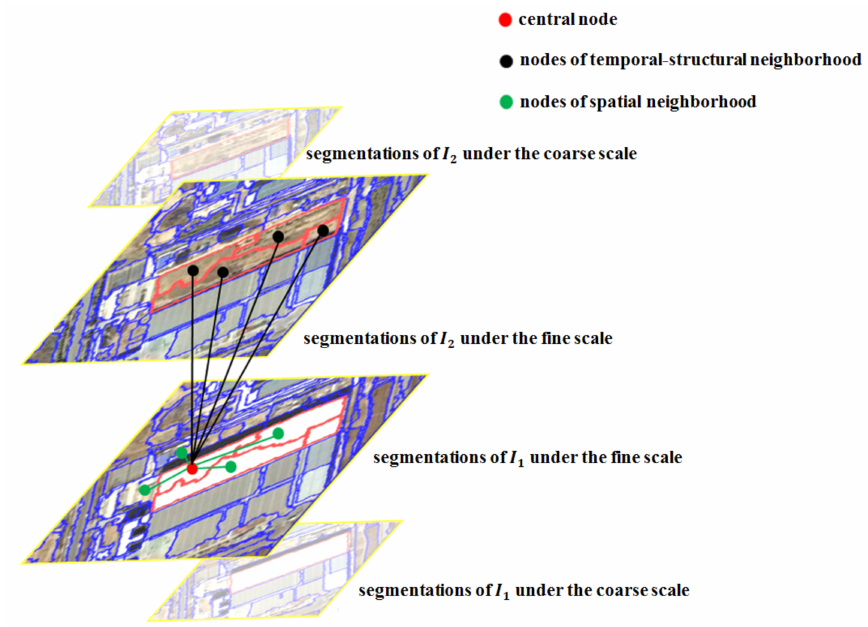
Figure 2. Illustration of nodes of a temporal-spatial-structural